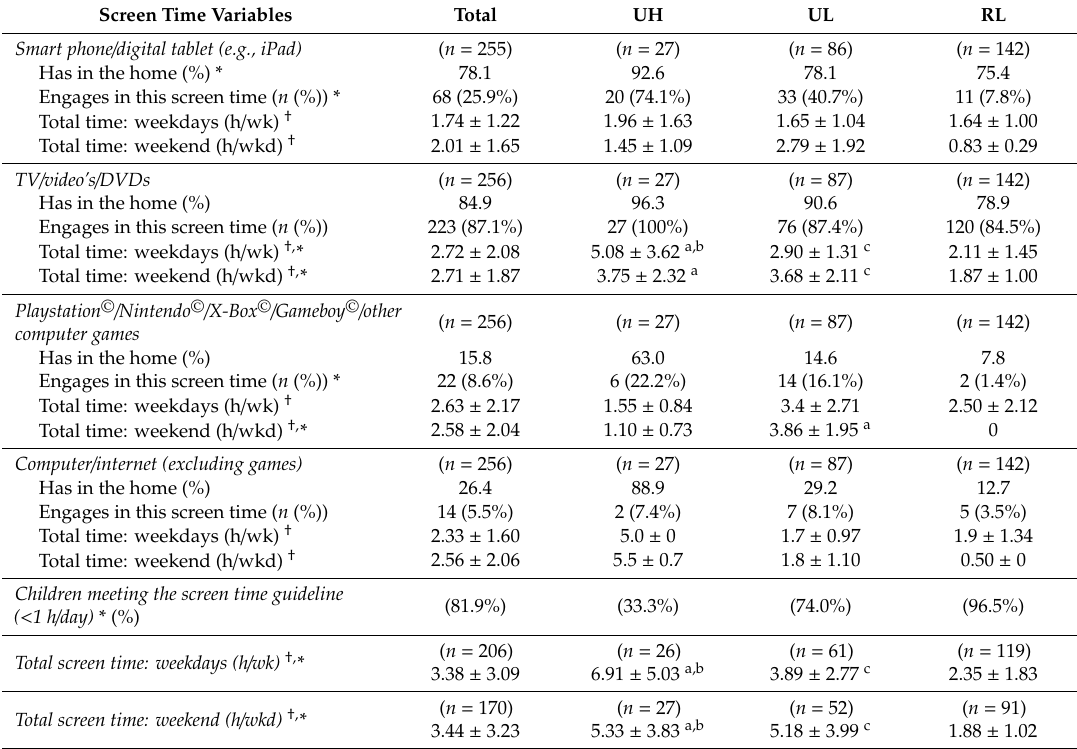
Table 2. Parent report of availability of screen devices and child screen time by